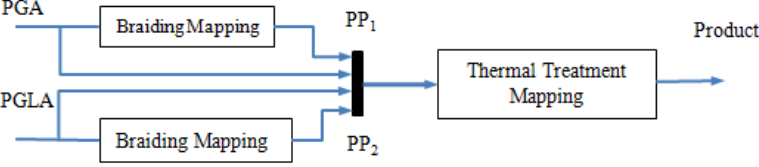
Figure 2. Mapping block diagram of the preparation process of the bicomponent ureteral stent.